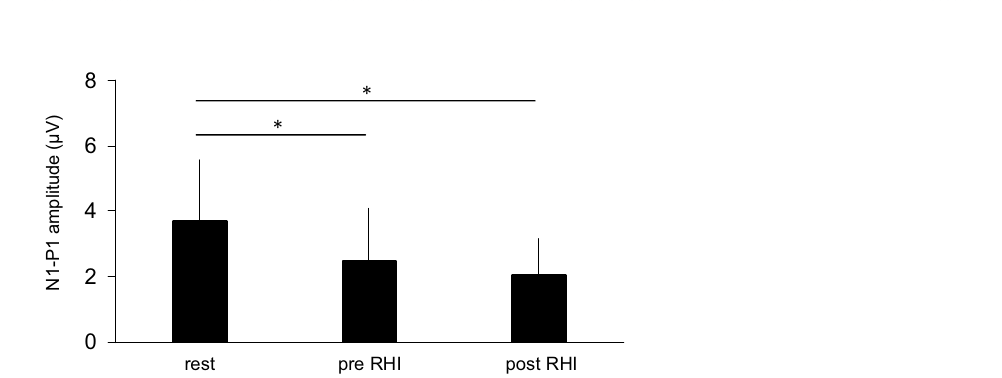
Figure 6. Grand averaged waveforms of somatosensory evoked potentials (SEPs) during all conditions in experiment 2.